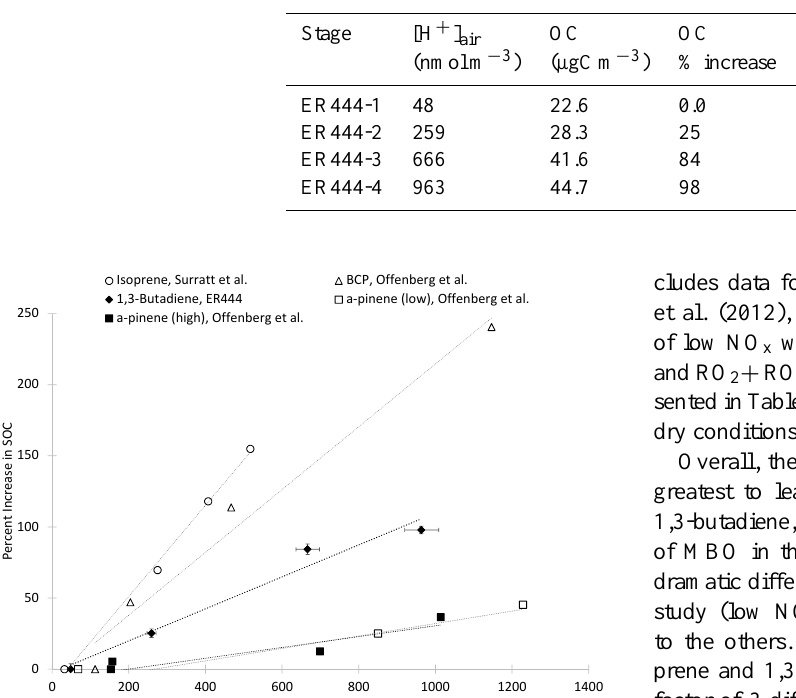
Table 2. Conditions and OC data for 1,3-butadiene photooxidation with the nebulized inorganic aerosol. For each stage, the initial 1,3- butadiene was 6.8ppmC, initial NO was 0.34ppm, and relative humidity was 30% (6.1gm − 3 absolute humidity).